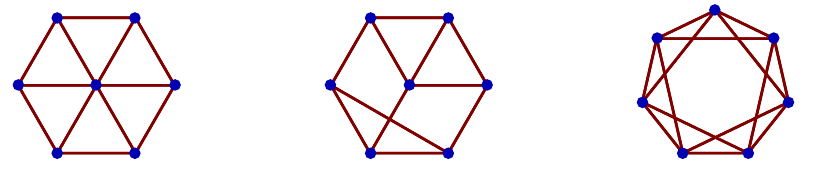
Figure 9 . Representatives from three distinct classes of T-equivalent codes, which maximize both d = 3 and d b = 4 . The interlace polynomials for these classes are Q = 40 x 7 +62 x 6 y +24 x 5 y 2 +2 x 4 y 3 , Q = 41 x 7 + 63 x 6 y + 23 x 5 y 2 + x 4 y 3 , and Q = 43 x 7 + 64 x 6 y + 21 x 5 y 2